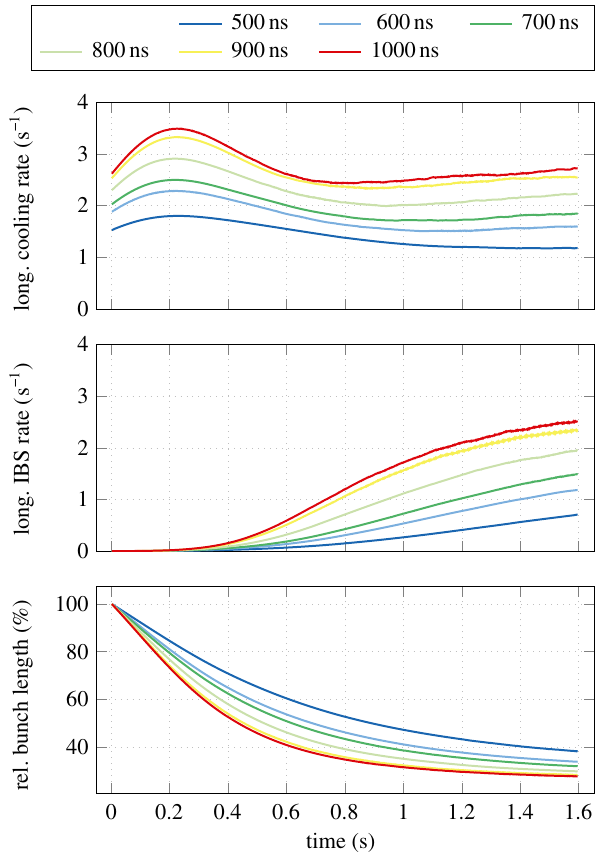
FIG. 17. Simulation of cooling rate, IBS rate, and ion bunch length with parameter sets similar to the experiment. Note that the definition of the rates used here refers to the emittance rather than the bunch length. The 400 ns case was omitted because this type of simulation cannot reproduce the effect of bunch length jitter. f ¼ 466 S